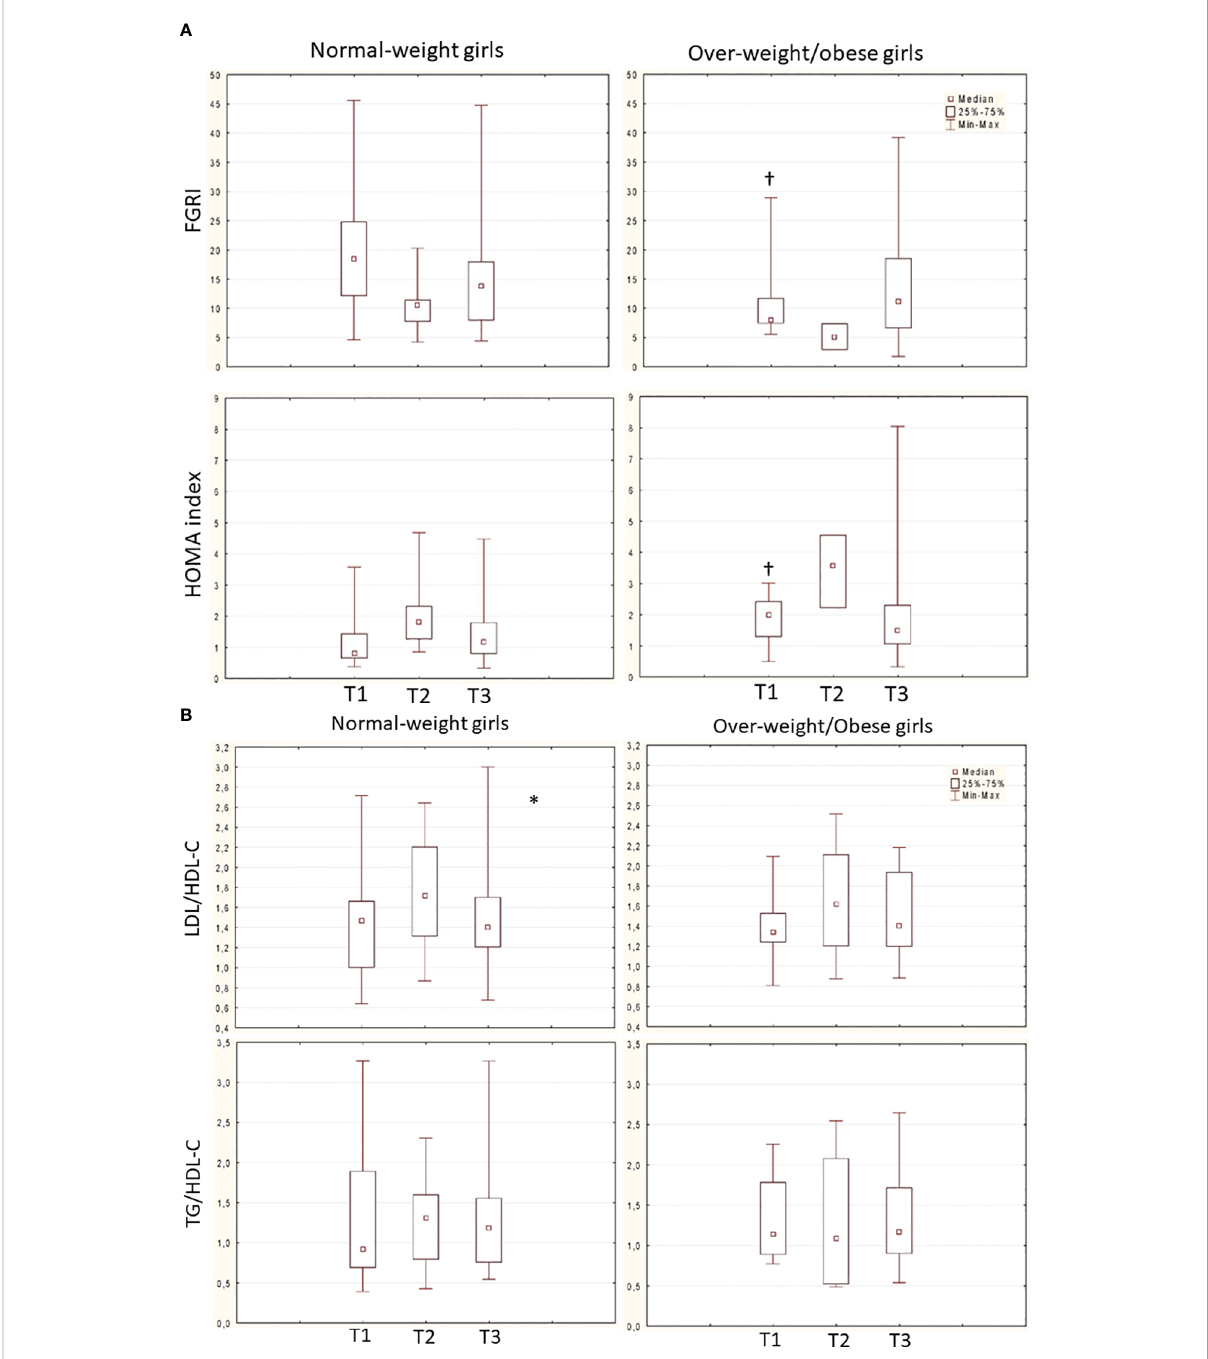
FIGURE 3 (A) Trend of FGRI (normal-weight: c 2 4.8, p 0.090; overweight/obese: c 2 4.66, p 0.969) and HOMA index (normal-weight: c 2 5.2, p 0.07; overweight/obese: c 2 4.66, p 0.096) over time in the 2 groups (Friedman ANOVA test). † p<0.050 Group A vs. B (mann-whitney U test). Data are expressed as median, 25°-75° percentile overlapped min and max at T2. (B) Trend of LDL/HDL-C ratio (normal-weight: c 2 7, p 0.030*; overweight/obese: c 2 1.5, p 0.473) and TG/HDL-C ratio (normal-weight: X 2 1.6, p 0.449; overweight/obese: c 2 4.6, p 0.096) over time in the 2 groups (Friedman ANOVA test, *p<0.05). Data are expessed as median, 25°-75° percentile and range